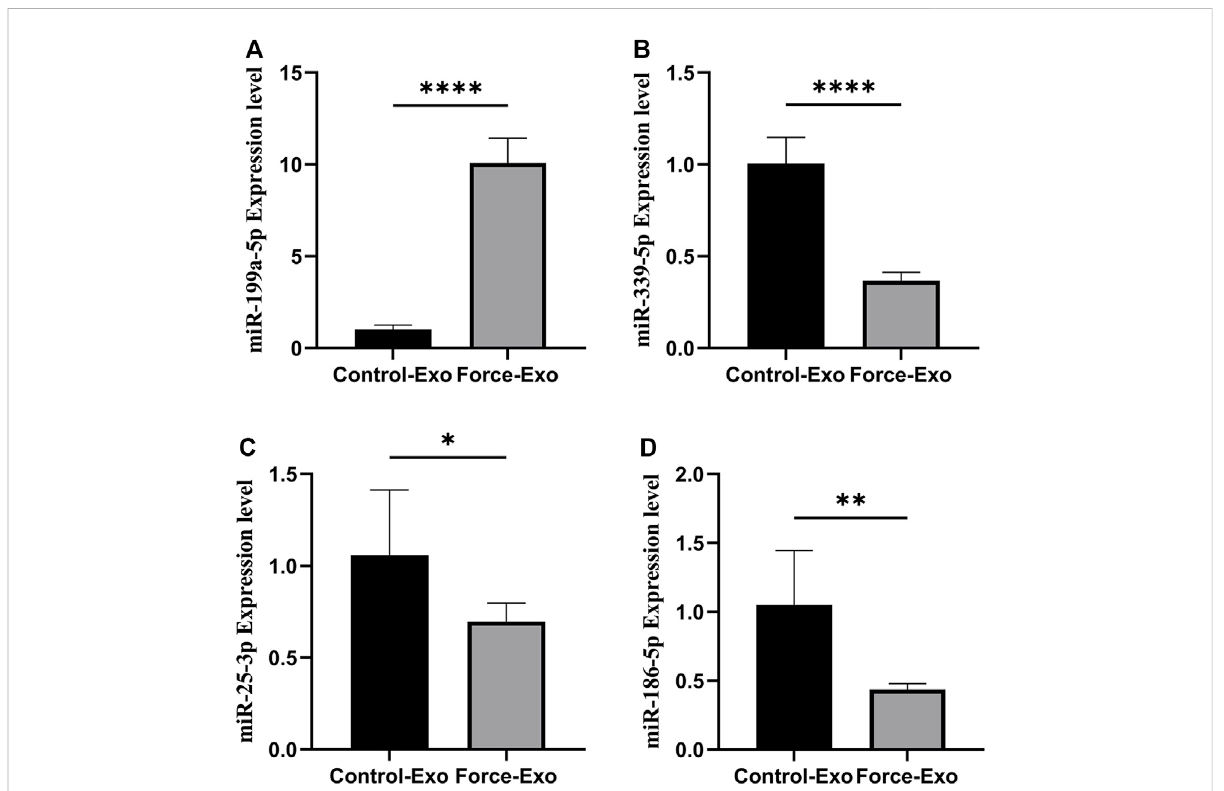
FIGURE 7 ValidationofdifferentialmiRNAexpressionpro fi les. (A) miR-199a-5Pexpressionincondylarchondrocyteswassigni fi cantlyhigherintheForce- Exo group than in the Control-Exo group, N = 3 for each group, **** p < 0.0001. (B) miR-339-5P expression in condylar chondrocytes was signi fi cantlylowerintheForce-ExogroupthanintheControl-Exogroup,N=3foreachgroup,**** p < 0.0001. (C) miR-25-3Pexpressionincondylar chondrocytes was signi fi cantly lower in the Force-Exo group than in the Control-Exo group, N = 3 for each group, * p < 0.05. (D) miR-186-5P expression incondylarchondrocyteswassigni fi cantly lowerintheForce-ExogroupthanintheControl-Exogroup,N=3foreachgroup, ** p <